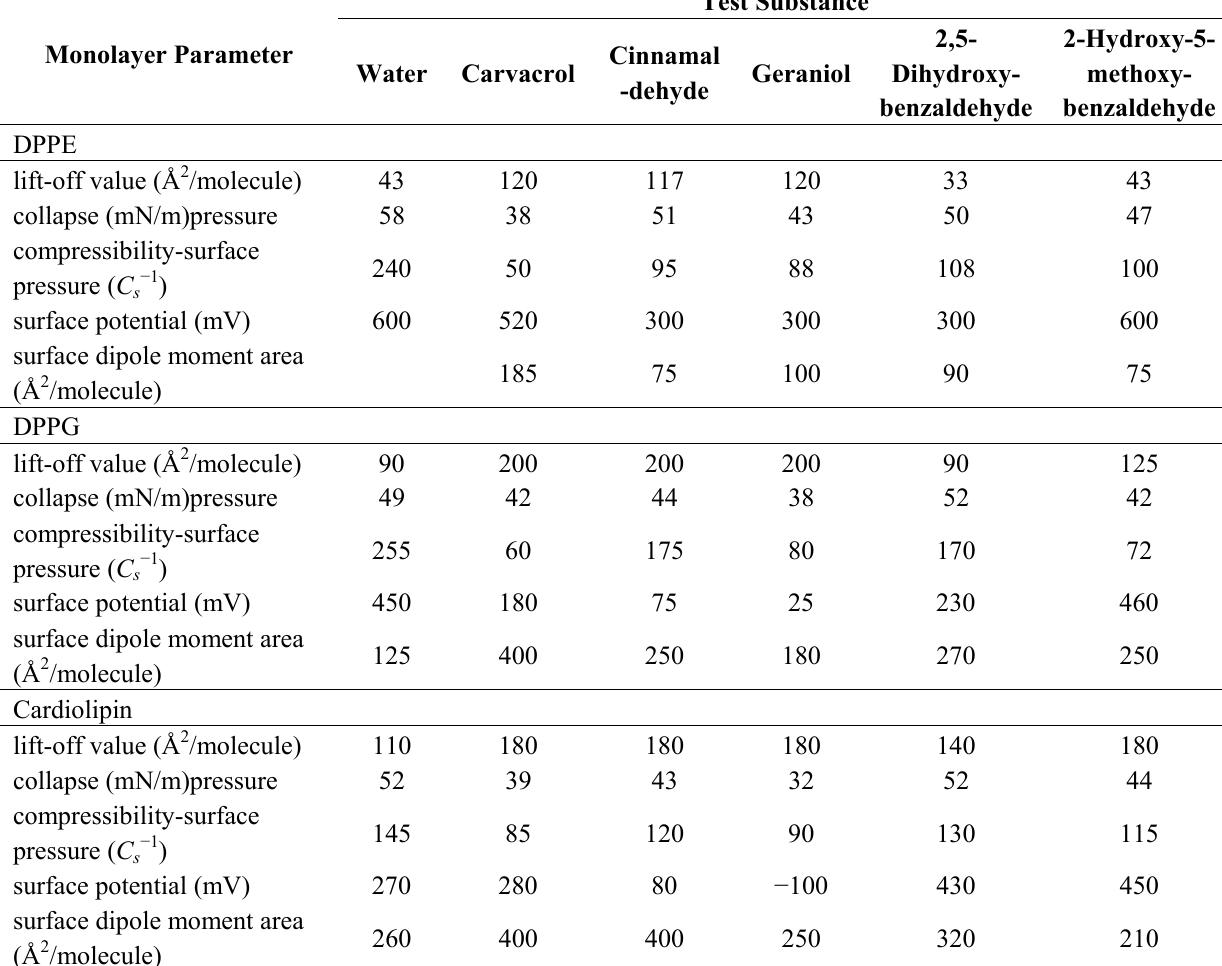
Table 1. Summary of experimental thermodynamic parameters for the interactions of five test compounds with three different phospholipid